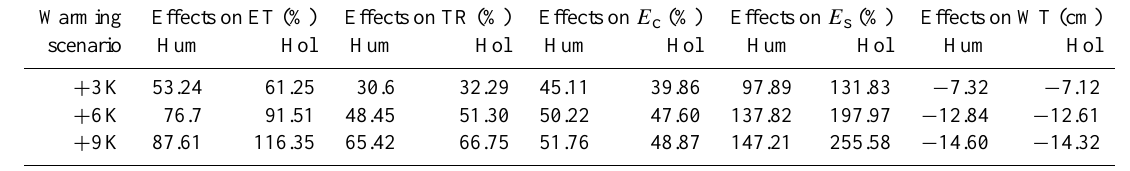
Table 2. The relative changes (as compared to the control) in annual ET and its components, and water table levels (WT) (averaged over the period of 2011 to 2013) in the hummock (Hum) and hollow (Hol) under different warming scenarios with constant Q experiments (TR, E c and E s are canopy transpiration, canopy evaporation and soil evaporation, respectively).